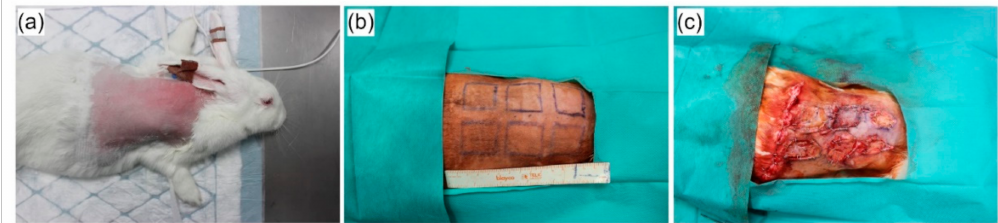
Figure 1. In vivo experiment on white New Zealand rabbits: ( a ) Animals were shaved at the places of wound surgery; ( b ) six defects were labeled on the shaved skin; ( c ) scaffolds (Coll, Coll/Chit and Coll/Chit_0.1 FGF2) were randomly implanted including empty defect-control group ( b ). Each group of implants was